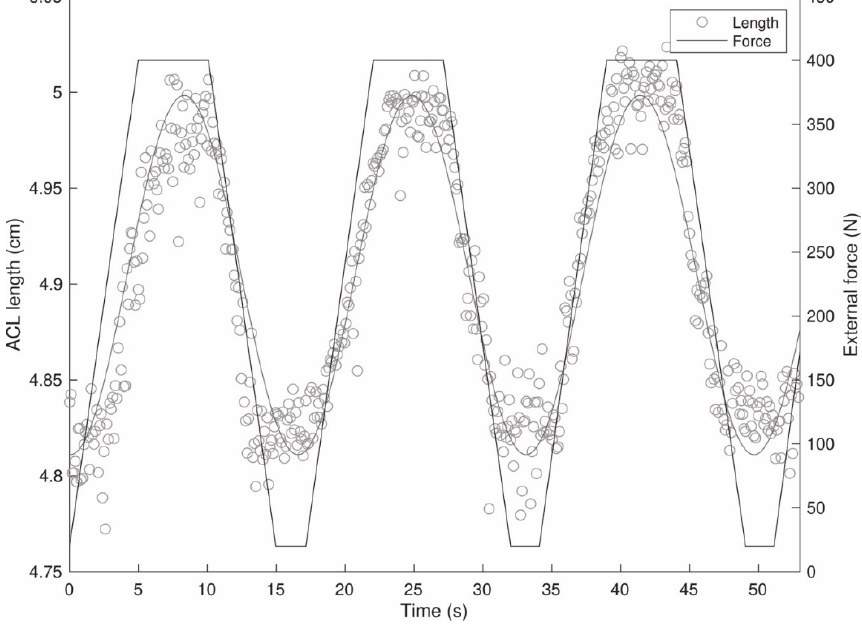
Figure 4. Demonstrative time-length and time-force data series.